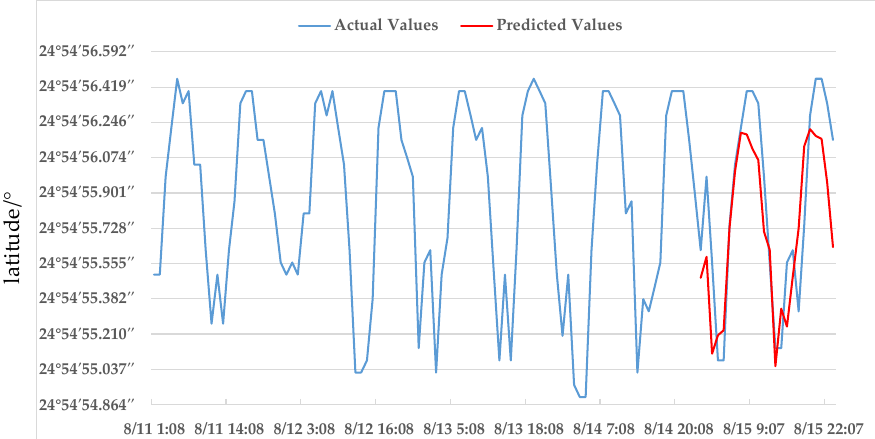
Figure 18. Comparison of longitude prediction.